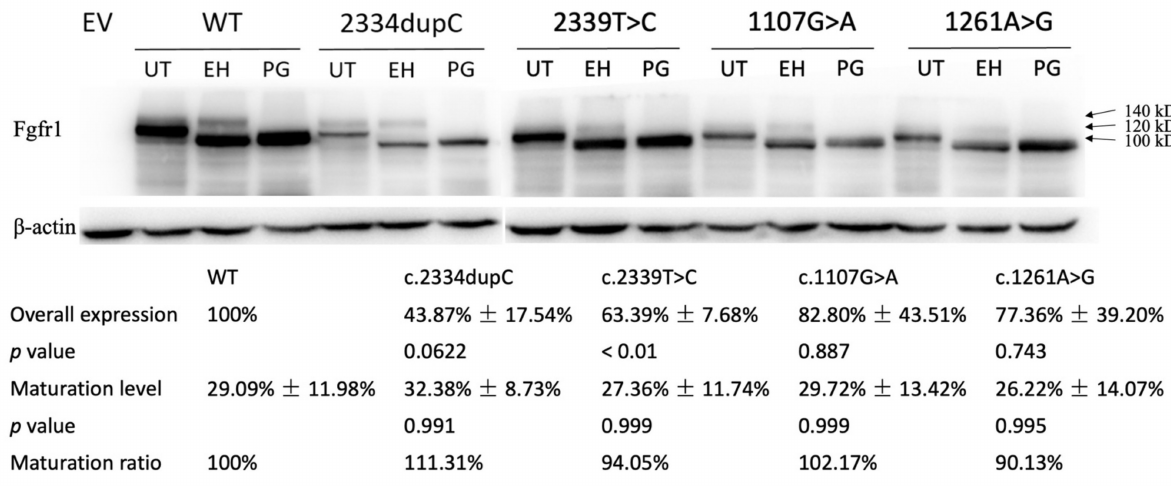
Figure 3. Western blot analysis of COS-7 cells transiently transfected with WT or mutant FGFR1 constructs reveal diminished protein expression levels of c.2334dupC, c.2339T>C, c.1107G>A and c.1261A>G. Overall expression was significantly decreased in all four variants, especially in c.2334dupC. No difference in protein maturation process was detected using a receptor deglycosylation. EV = empty vector, WT = wild type, UT = untreated, EH = EndoH-treated, PG = PNGase-f-treated.